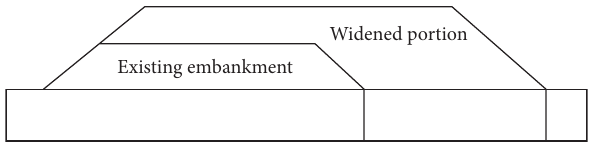
Figure 1: Schematic diagram of the new and existing